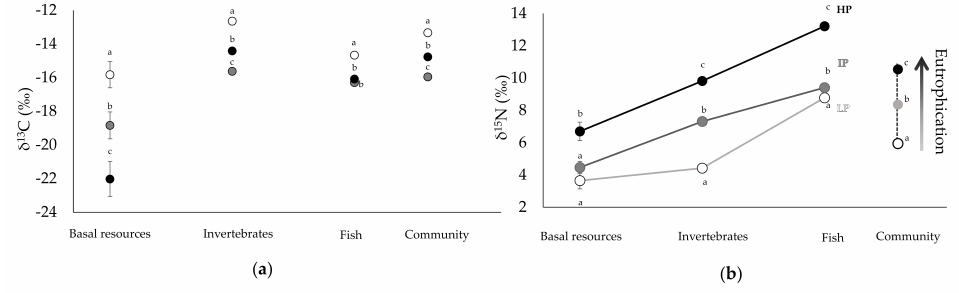
Figure 3. δ 13 C (a) and δ 15 N (b) values (% (cid:24) ) of basal resources, invertebrates, fish and the whole animal community in each lake. LP, IP and HP: low, intermediate and high eutrophication. Isotopic values are reported as mean ± s.e. Greyscale indicate degrees of eutrophication: LP (white), IP (grey), HP (black). Arrow indicates increasingly eutrophic conditions. Di ff erent letters (a, b, c) within panels indicate di ff erences between lakes (Mann–Whitney test with Bonferroni correction for multiple comparisons; p -value < 0.05).